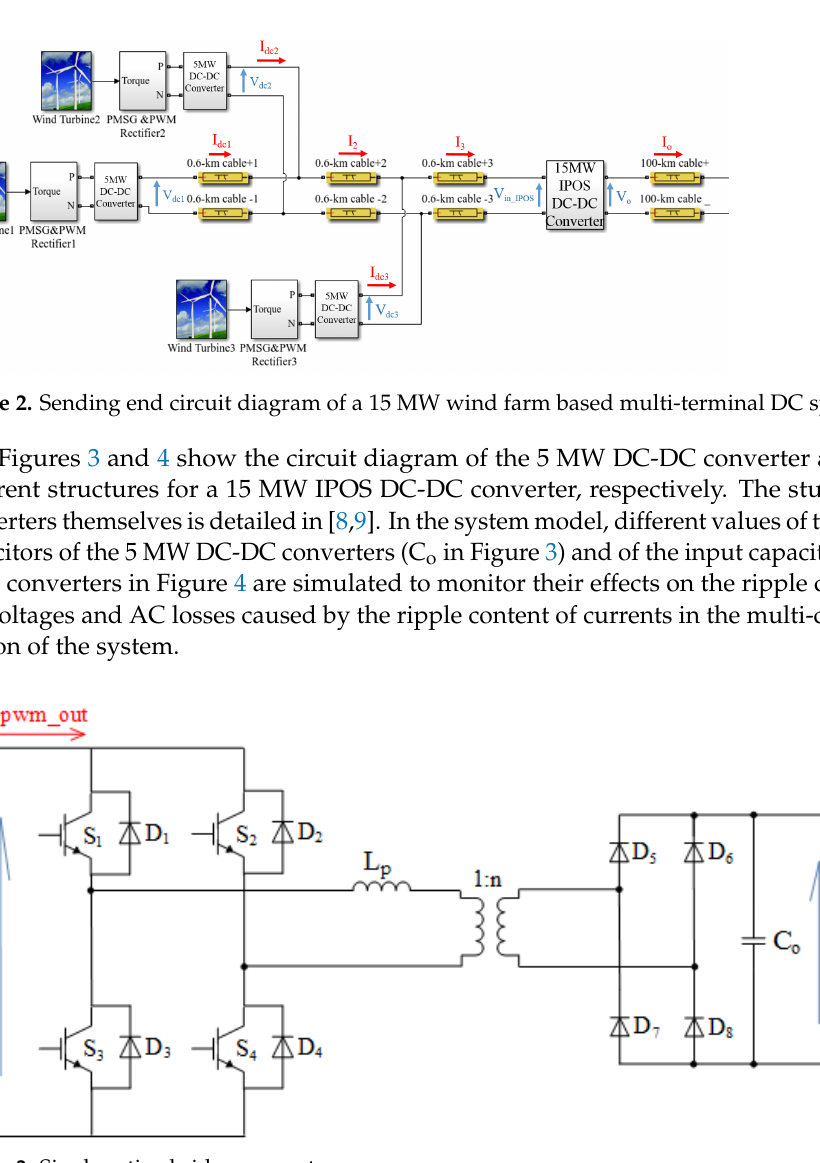
Figure 1. Simplified diagram of the multi-connected system.